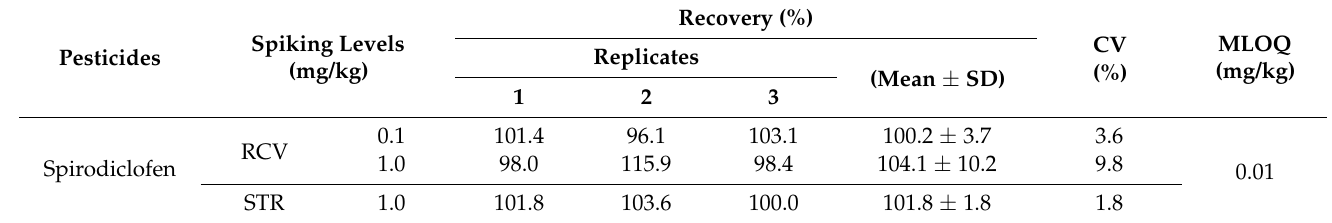
Table 2. Recovery (RCV) and storage stability (STR) data for spirodiclofen and tebufenpyrad in Aster scaber